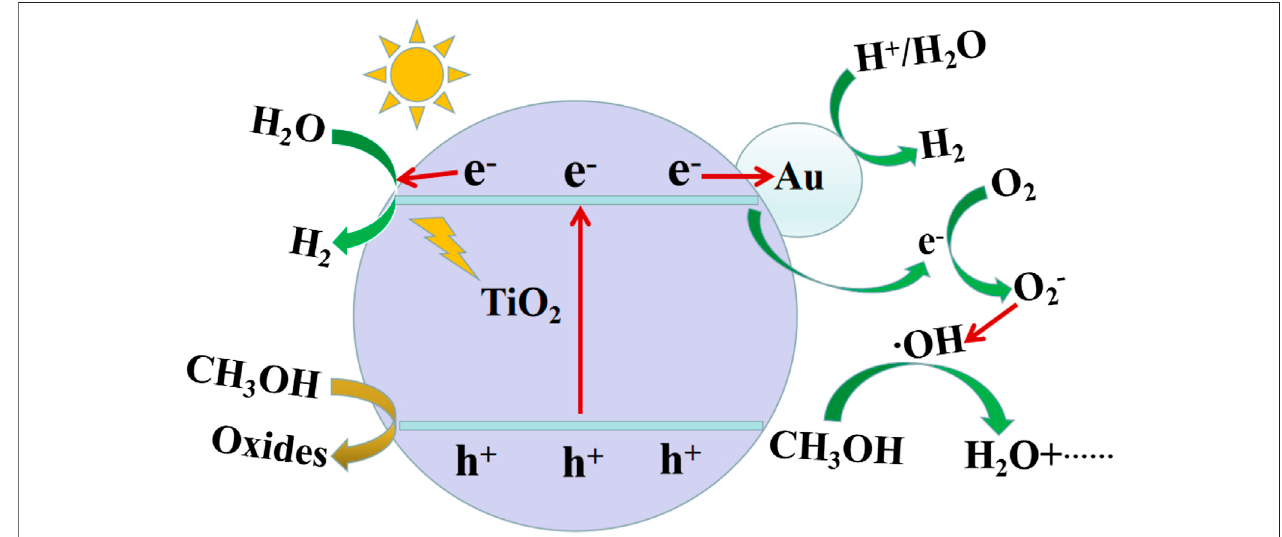
FIGURE 8 | Schematic diagram of charge transfer and H 2 production of Au/D-TiO 2